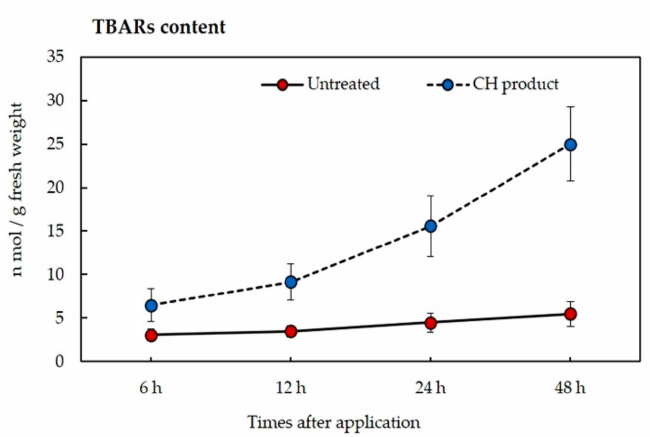
Figure 7. The amounts of TBARs in E. crus-galli at the increasing times after post-emergence appli- cation of CH product under pot experiment in glasshouse conditions. Means expressed error bar ( ± SE) with four